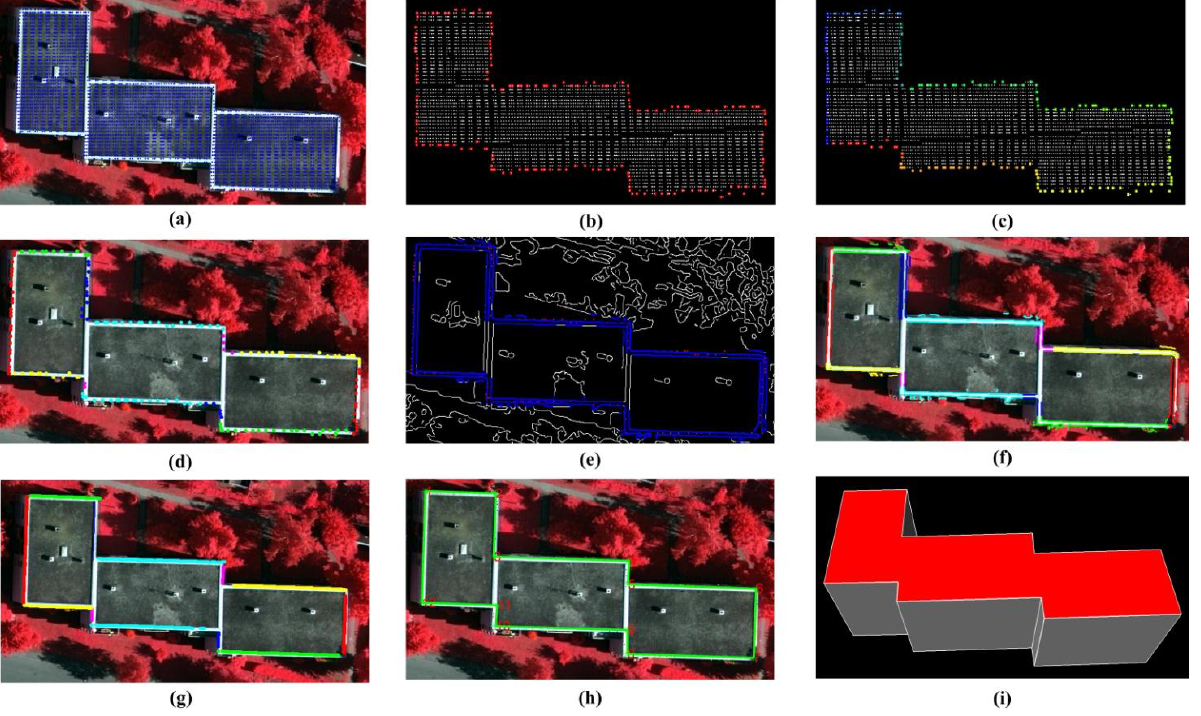
Figure 12. Reconstruction of a complex flat building with polygonal shape. ( a ) The segmented planar patch of a complex flat roof (blue points); ( b ) the extraction of 3D boundary points (red points); ( c ) the grouping result of the 3D boundary points; ( d ) the grouping boundary points that are back projected onto the aerial imagery; ( e ) edge detection on the sub-image; ( f ) edge pixels in the neighborhood of the back-projected boundary points; ( g ) inliers of the RANSAC; ( h ) results of 2D corner extraction; and ( i ) the reconstructed 3D flat building